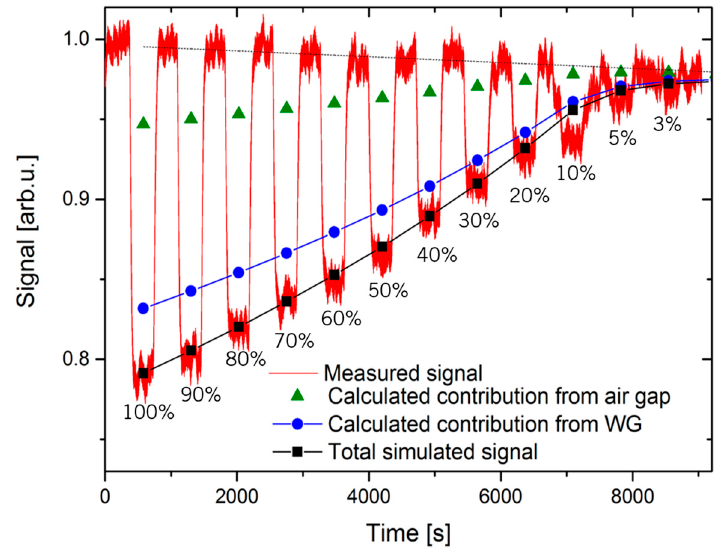
Figure 2. Measured signal at the detector (red solid line) for the gas concentrations indicated in the plot. Triangles and circles are the change in transmittance (calculated according to the Beer-Lambert law) due to absorption in the air gap and of the waveguide evanescent field, respectively. Square symbols show the calculated total signal accounting for both